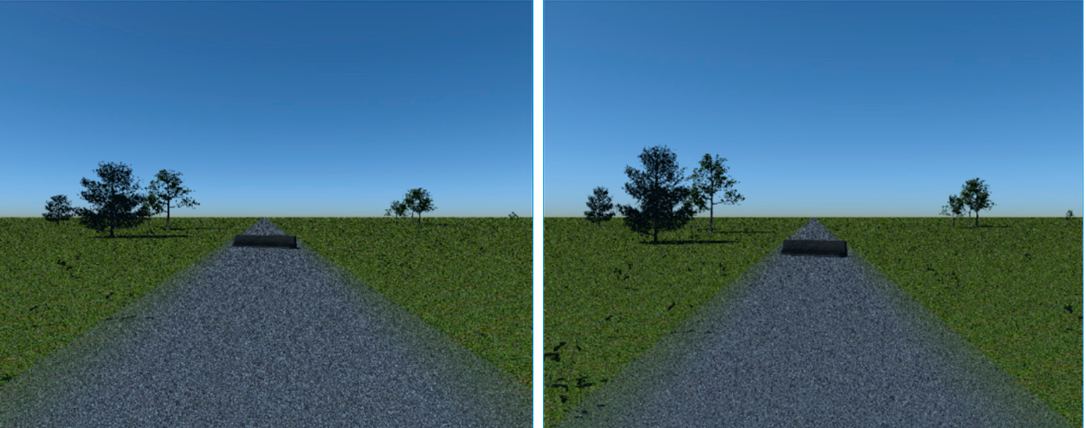
Figure 3. Example of the effect of distortion in the MAVS camera simulation. ( Left ) Distorted image. ( Right ) Undistorted